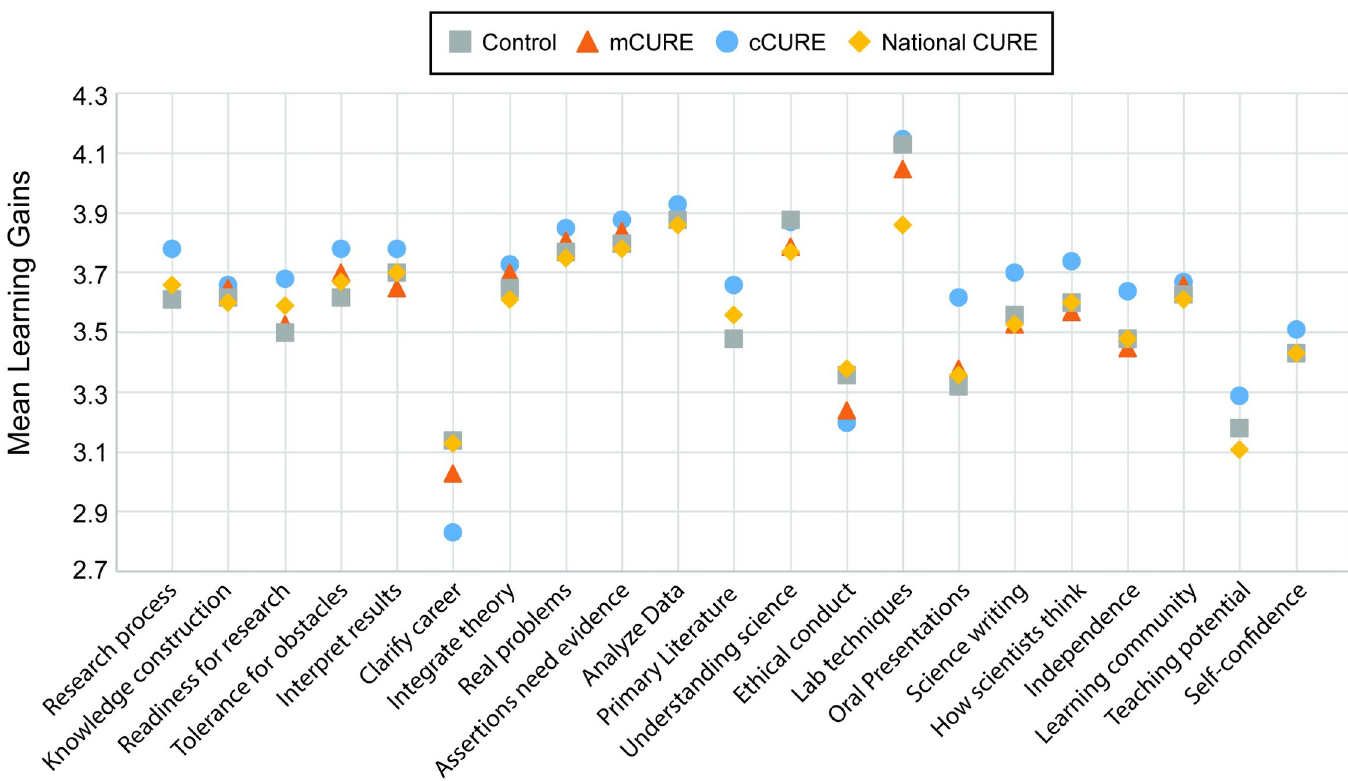
Fig 6. CURE students self-reported learning gains are not significantly different from control courses. Students self-reported learning gains on 21 items at the end of the semester from 1 = “No gain or very small gain” to 5 = “Very large gain.” A national dataset of CURE responses [64] is included. ANOVAs found no significant differences in student self-reported learning between the three conditions. Thirteen items in the national CURE dataset (yellow dots) fall within the range of the control, mCURE, and cCURE courses in the MCC dataset. See S4 Table for complete results.